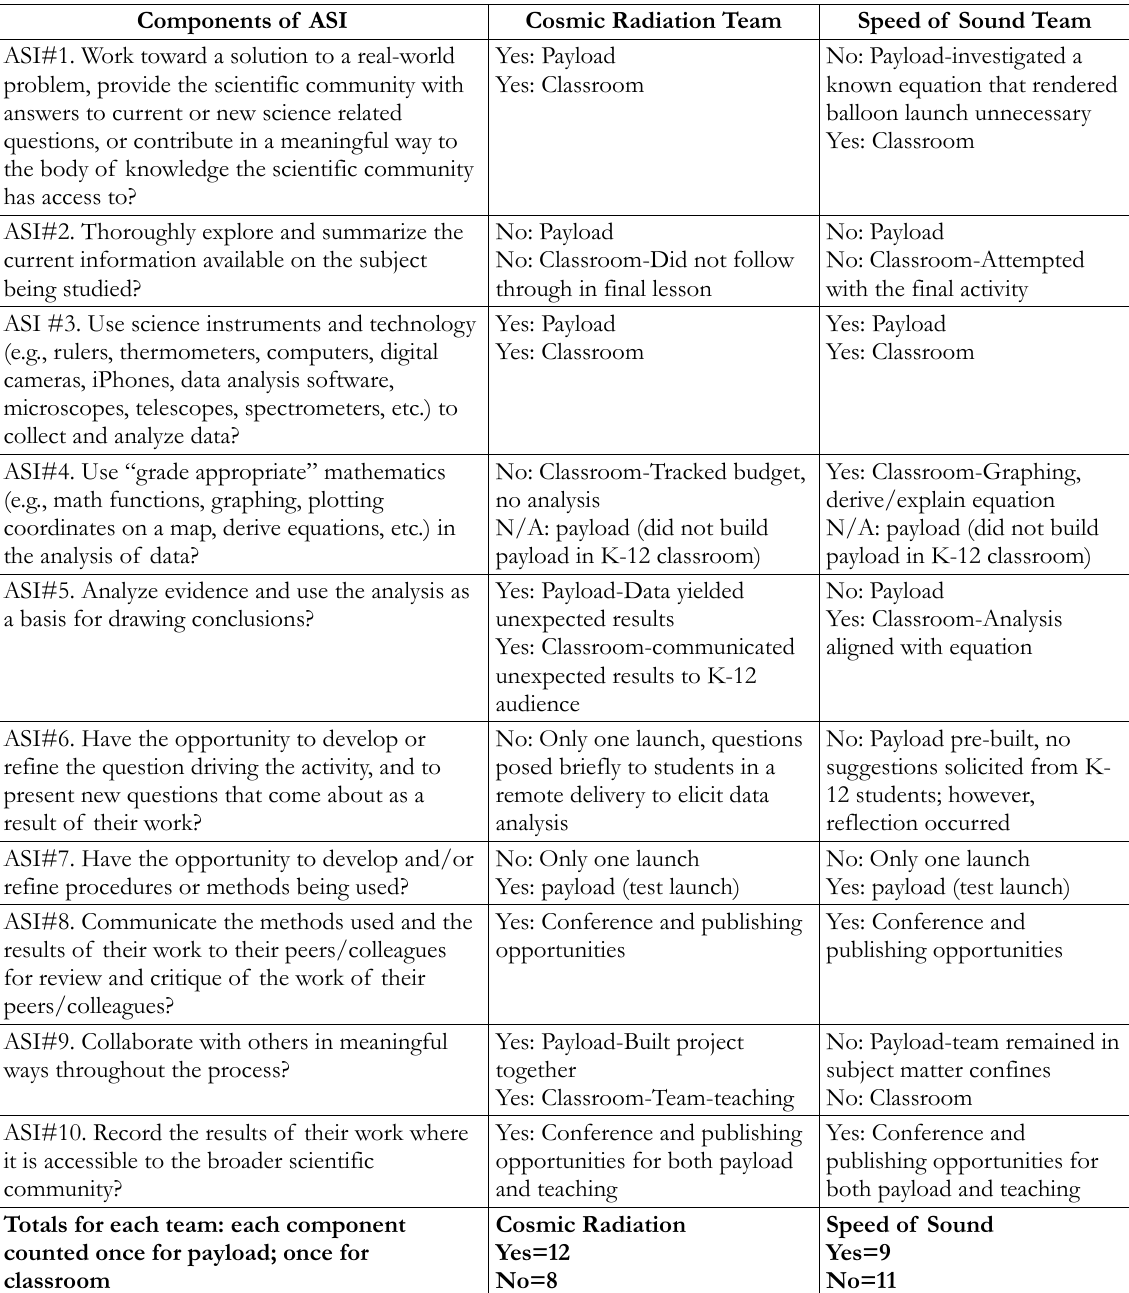
Table 2. Assessment of teams by ASI